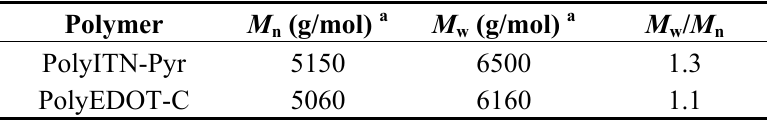
Table 1. Polymerization